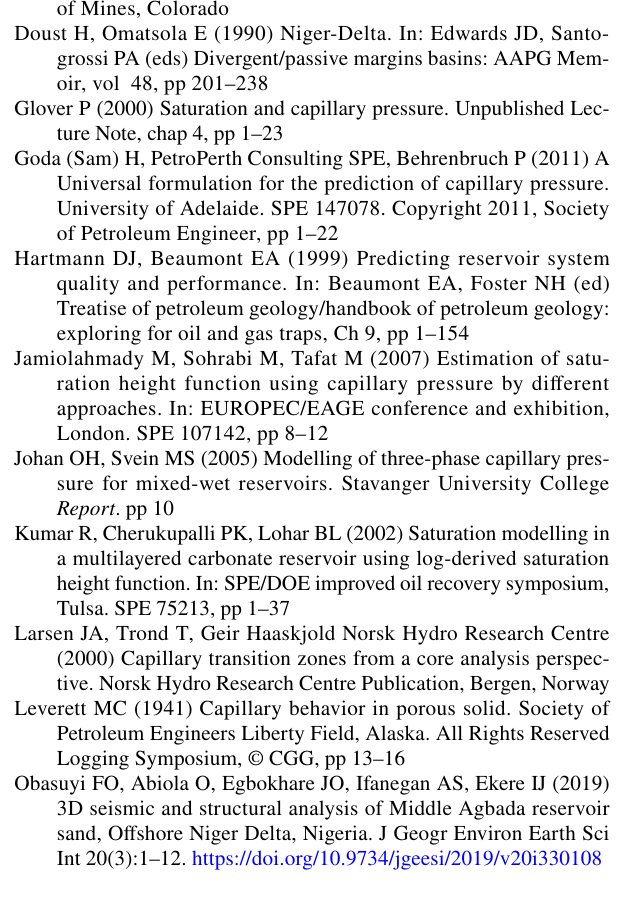
Fig. 14 Capillary pressure curves for reservoirs B and C Table 5 Volume of oil without transition zone analysis and with